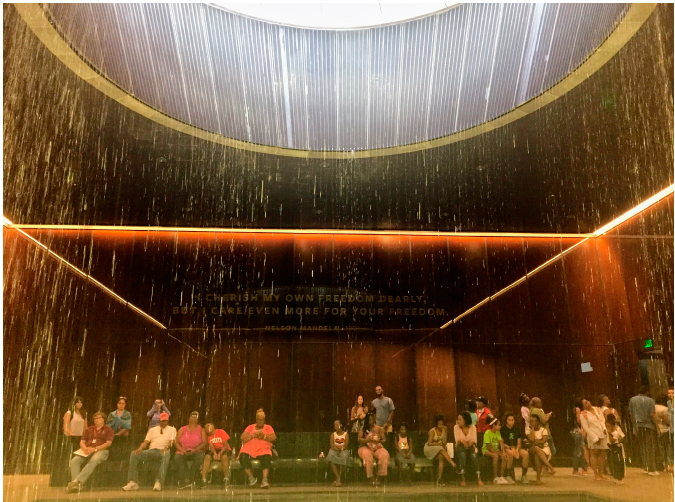
Figure 4. The interior contemplative court of the National Museum of African American History and Culture, June 2017.